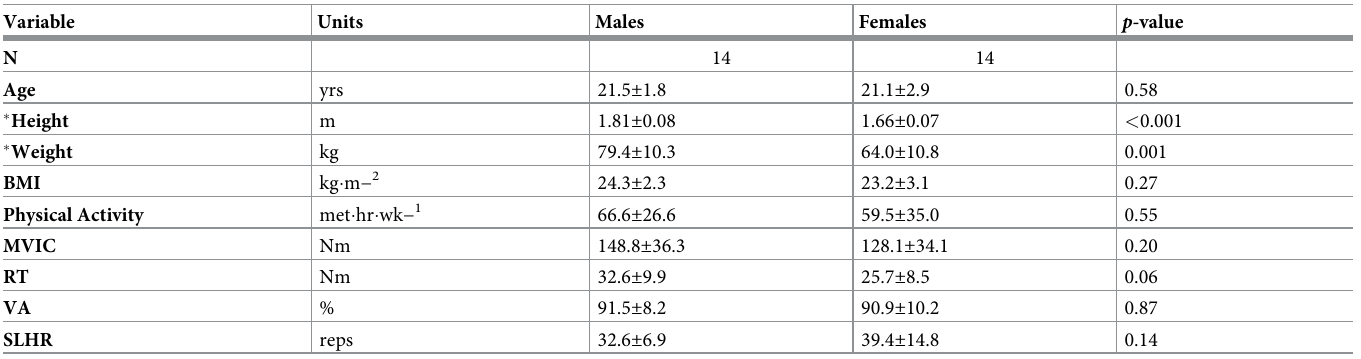
Table 1. Participant demographics & baseline